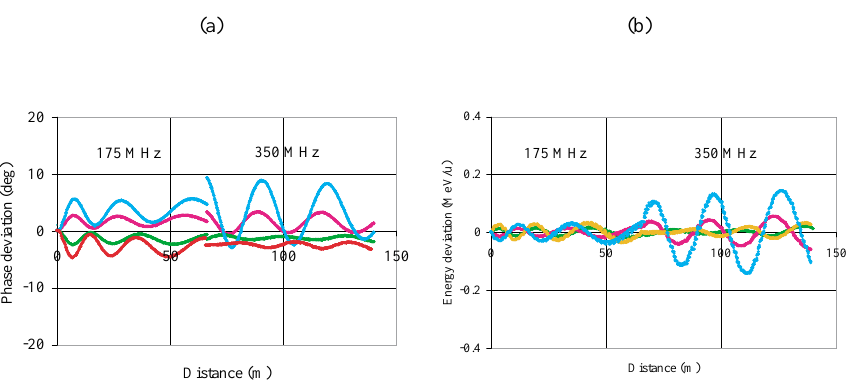
FIG. 6. (Color) Phase (a) and average energy (b) oscillation of multiple charge beam ( q (cid:1) 73 , 74, 76, and 77) with respect to the charge state q 0 (cid:1) 75